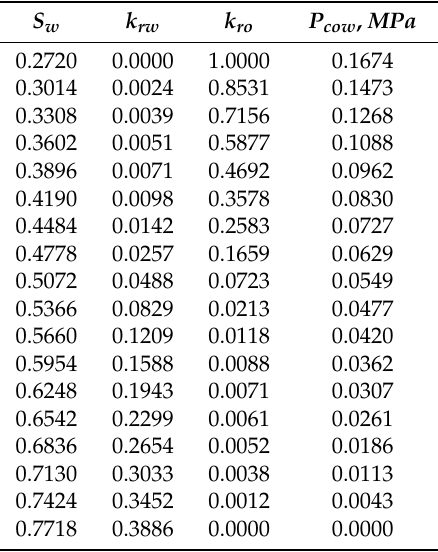
Table 10. Relative permeabilities and capillary pressures used in the simulation running the heavy oil displacement